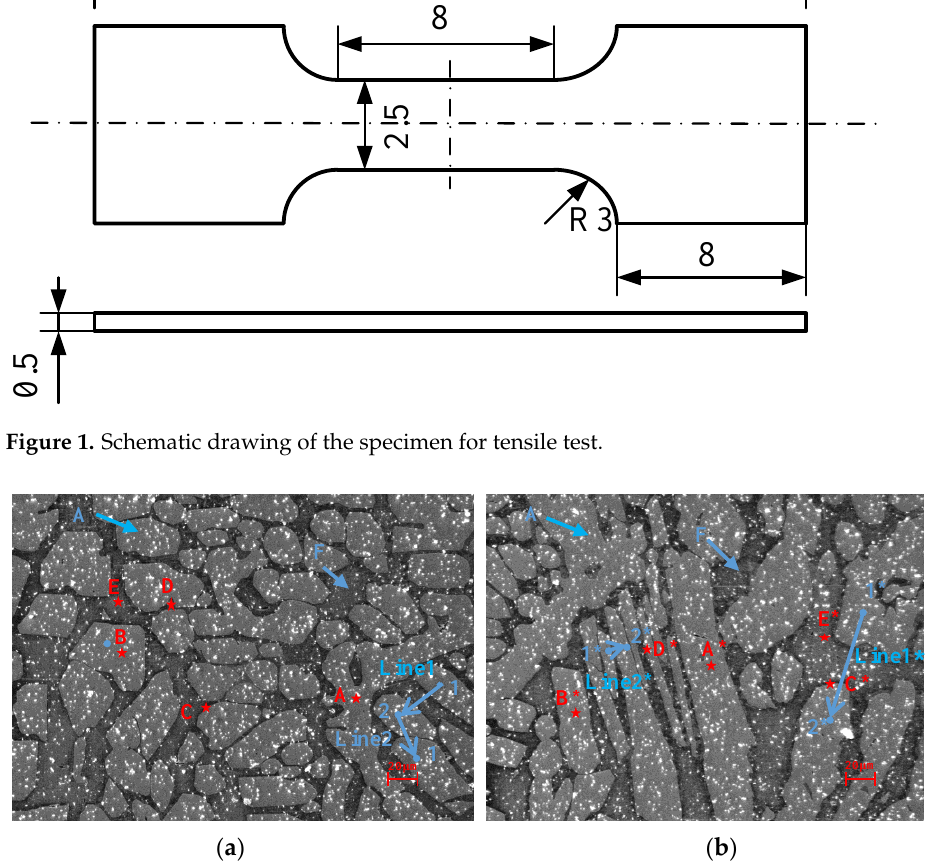
Figure 2. Representative areas after applying speckle: ( a ) uniform grain distribution area (1#) and ( b ) vertical fence-shaped grain area (2#).